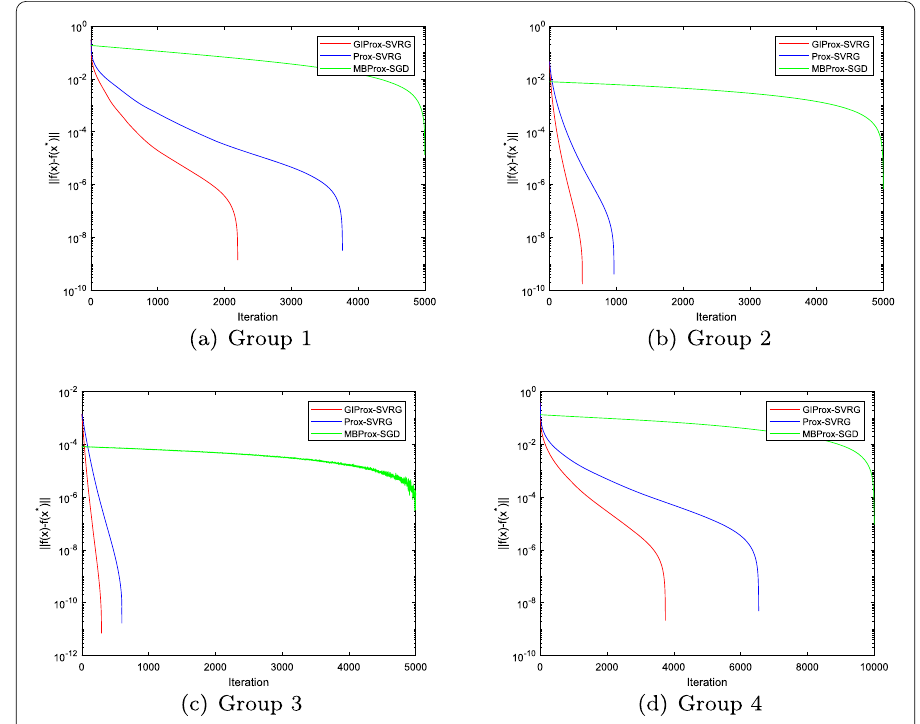
Figure 1 The change curve of objective function value of different algorithms on logistic regression